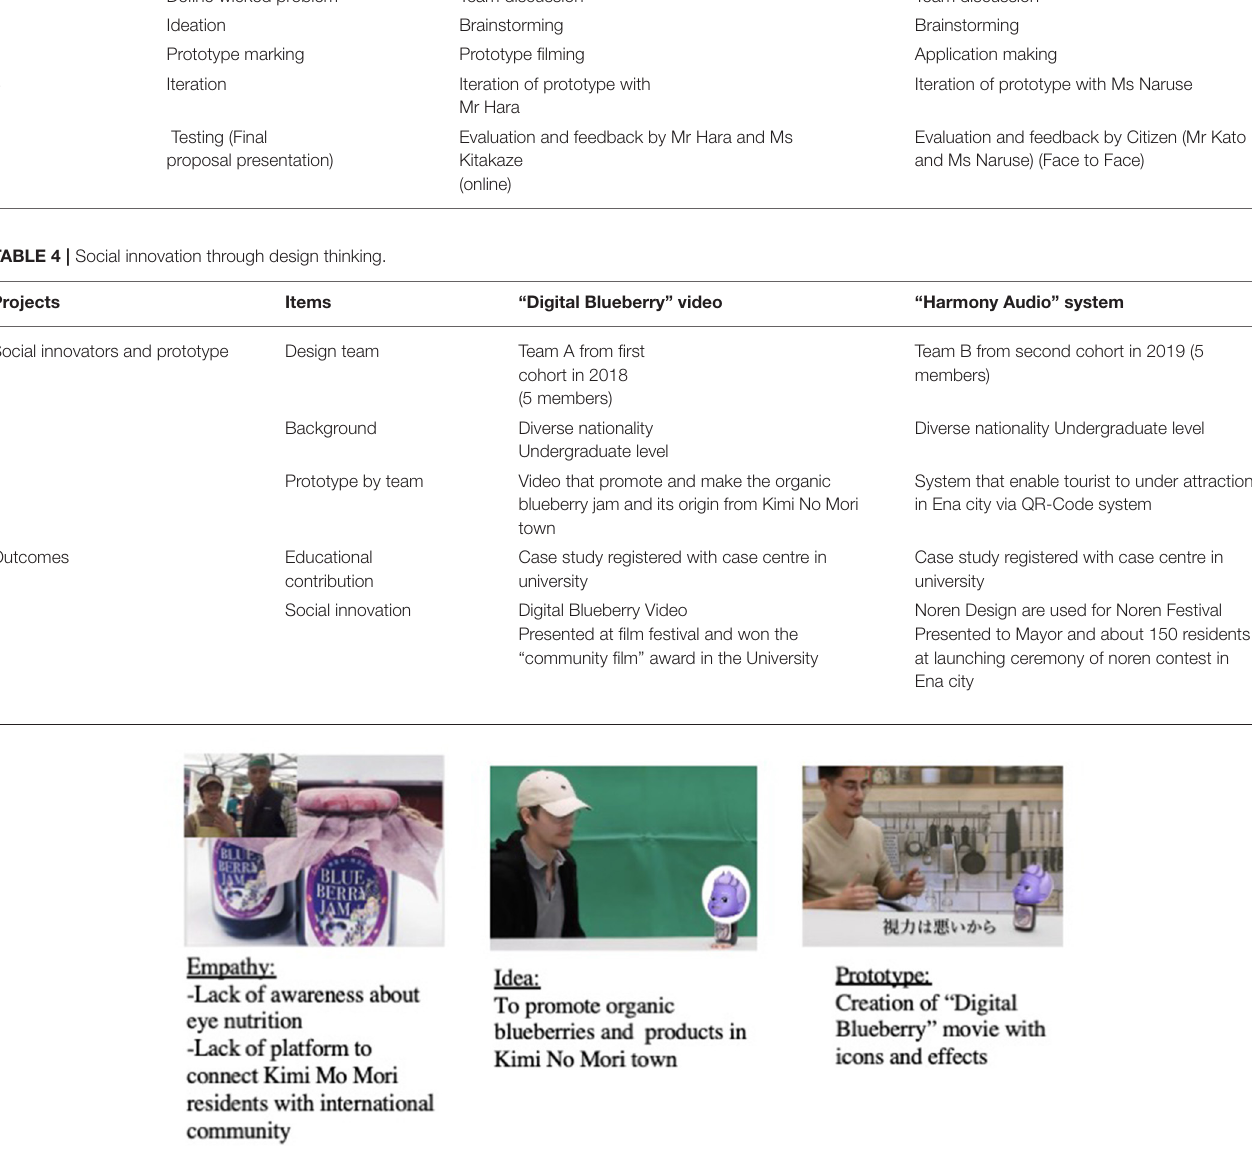
FIGURE 1 | “Digital Blueberry” video for Kimi No Mori estate.